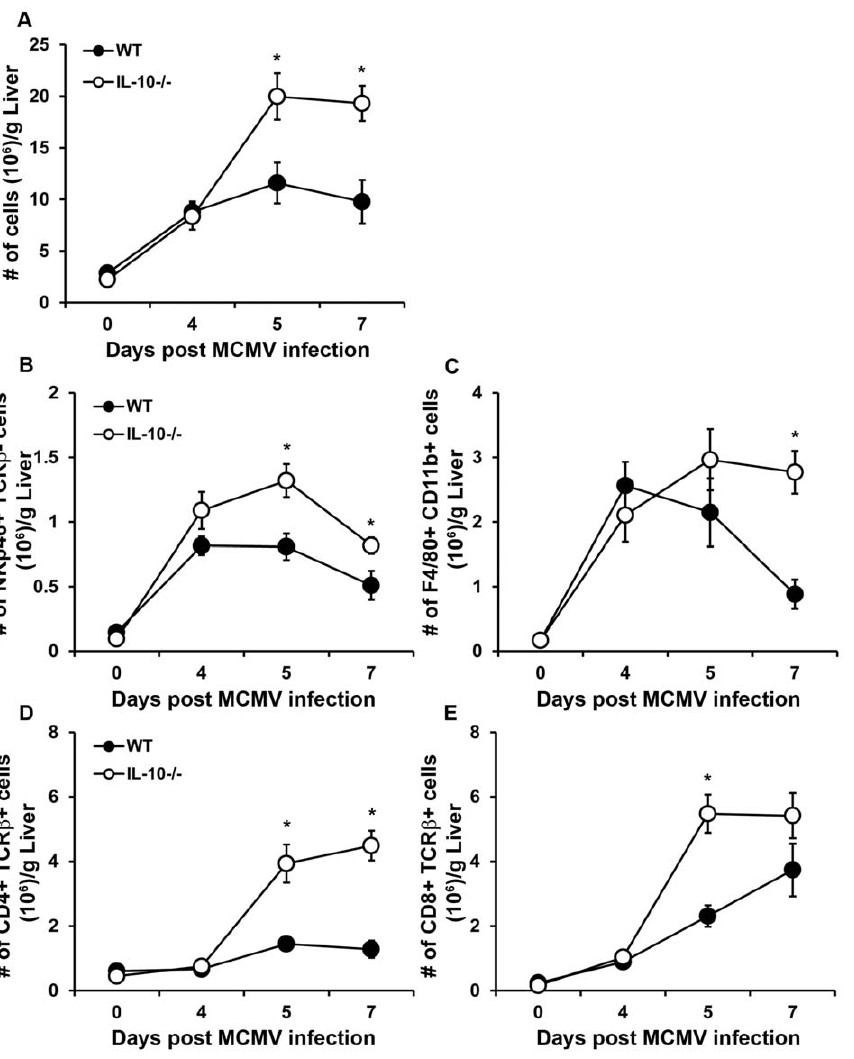
Figure 4. Effects of IL-10 deficiency on accumulation of inflammatory leukocytes after acute MCMV infection. Liver leukocytes were prepared from C57BL/6J (WT) or IL-10 2 / 2 mice that were left uninfected or infected with MCMV for 4, 5, and 7 days. (A) The mean total liver leukocyte numbers per gram liver 6 SE are shown. (B, C, D, E) Flow cytometry of effector cell populations within these total liver leukocyte populations were performed for time points indicated. Presented are the mean cell numbers per gram liver 6 SE for (B) NK cells (NKp46 + TCR b 2 ), (C) macrophages (F4/ 80 + CD11b + ), (D) CD4 + T cells (CD4 + TCR b + ), and (E) CD8 + T cells (CD8 + TCR b + ). (A–E) Results shown are the combined data of three independent experiments (n=4–15 mice per group for each time point tested). Asterisks denote statistically significant differences between WT and IL-10 2 / 2 groups, where p values are # 0.05 (Student’s T test).